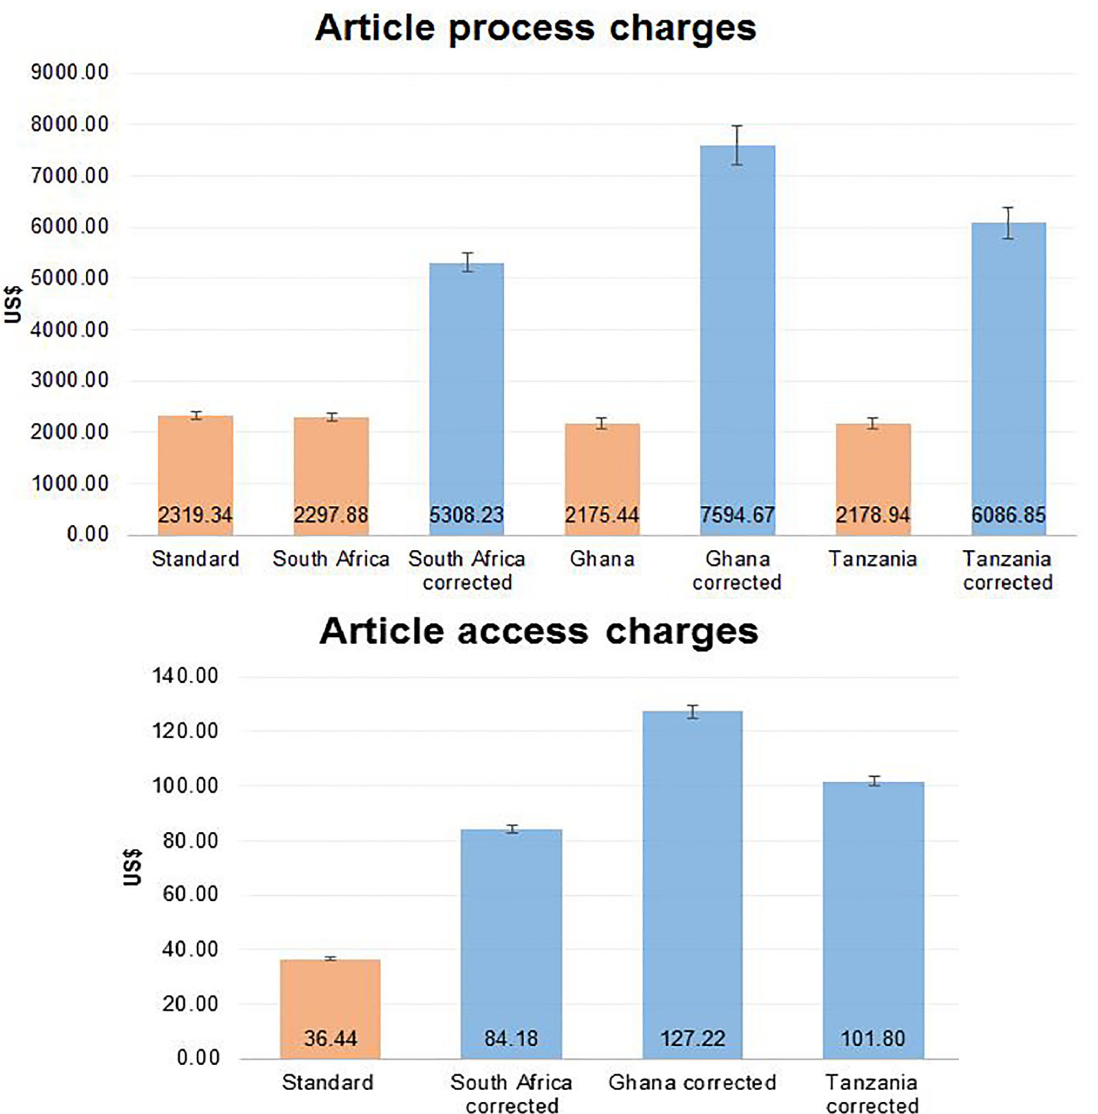
Figure 2. Article-process charges at the top with access charges below. The red bars indicate standard charges and blue bars indicate purchasing power parity-corrected charges. The error bars indicate the 95% confidence